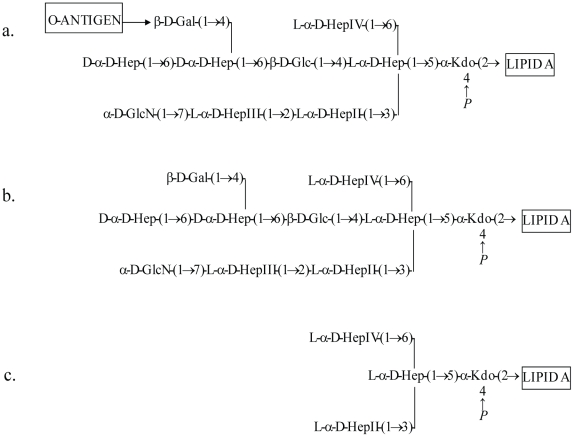
LPS structures of A. hydrophila AH-3 wild type (a), AH-3 ΔwaaL mutant (b), and AH-3 ΔwaaE mutant (c).